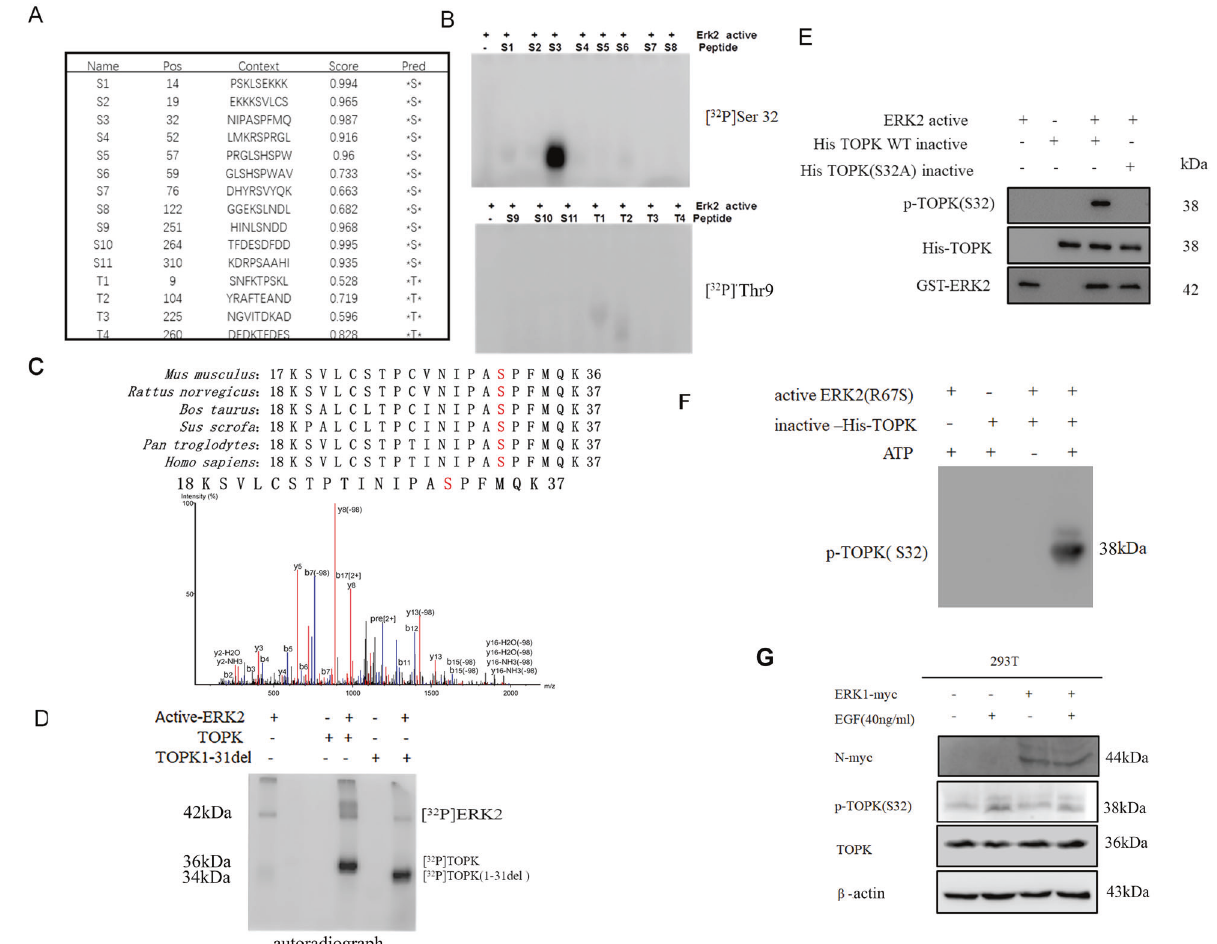
Fig. 2 ERK2 phosphorylate TOPK at Serine 32. A Potential phosphorylated serine and threonine sites of TOPK were predicted by NetPhos3.0 software program. B ERK2 phosphorylated TOPK at S32 in peptide mapping. Synthesized peptides containing potential serine [11] and threonine [4] sites were used as substrates in an in vitro kinase assay with active ERK2 in the presence of [ γ - 32 P] ATP. The results were visualized by autoradiography. C The production was obtained from the inactive HIS- TOPK as a substrate of active ERK2 protein by in vitro kinase assay, following the puri fi cation and detection of SDS-PAGE, and then the phosphorylation site of TOPK was analyzed by mass spectrometry using Agilent 7100-6545 instrument. D The autoradiograph of active ERK2 which phosphorylated inactive total TOPK or segment TOPK (deleted 1-31 amino acids) in the presence of [ γ - 32 P] ATP by in vitro kinase assay. The active ERK2 phosphorylate TOPK at S32 detected by anti-phospho-TOPK (S32) (p-TOPK (S32)) in vitro kinase assay. E Wild type His-TOPK (WT) and single mutant His-TOPK (S32A) was used as substrate of active ERK2. Reactive products were determined by Western blot with anti-p-TOPK (S32). F Wild type His-TOPK (WT) and mutant His-TOPK (S32A) were used as substrates of autophosphorylation ERK2_R67S in the presence or absence of ATP, and the production was determined by western blot with anti-p-TOPK (S32). G pCMV-ERK1-myc or pCMV was transiently transfected into 293T cells. Then the cells were harvested after stimulation with or without EGF and p-TOPK (S32) was determined by